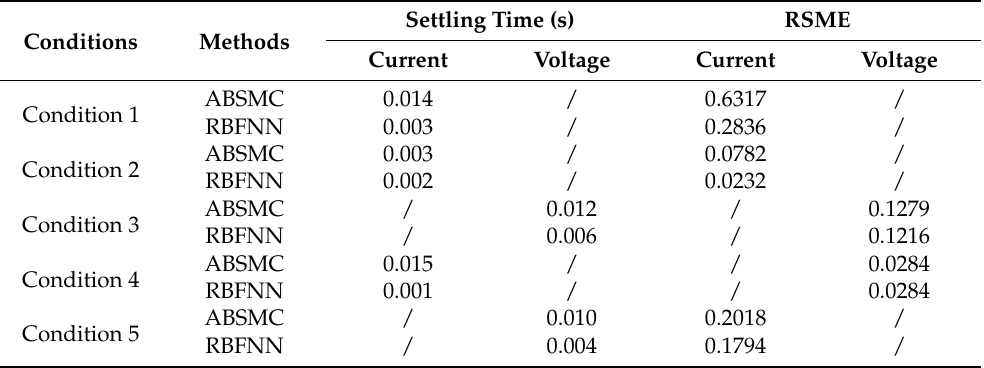
Figure 7. Simulation results in Condition 4: ( a ) by adaptive backstepping SMC; ( b ) by RBFNN. Table 3. Control comparison results under Conditions